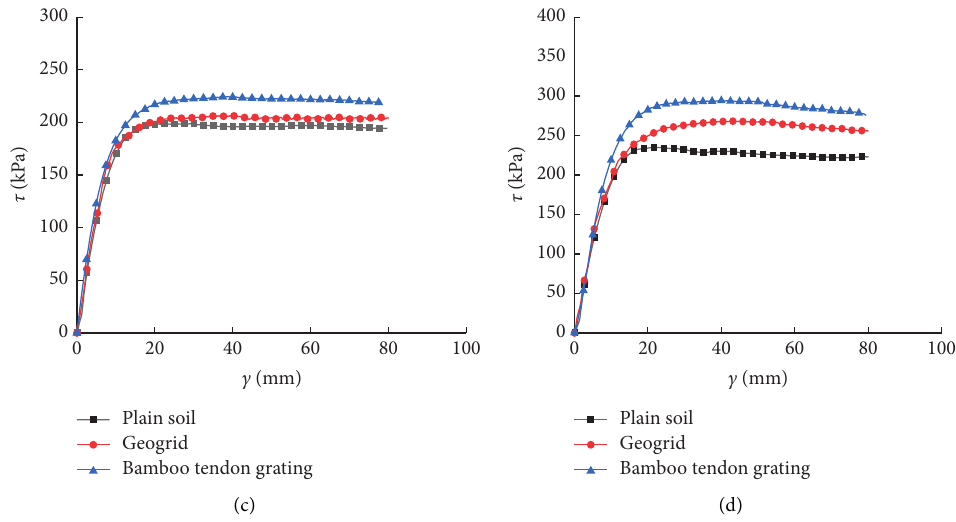
Figure 11: Shear stress-displacement curves of the reinforcement material interface under different normal stress levels: (a) 100kPa normal stress, (b) 200kPa normal stress, (c) 300kPa normal stress, and (d) 400kPa normal stress.